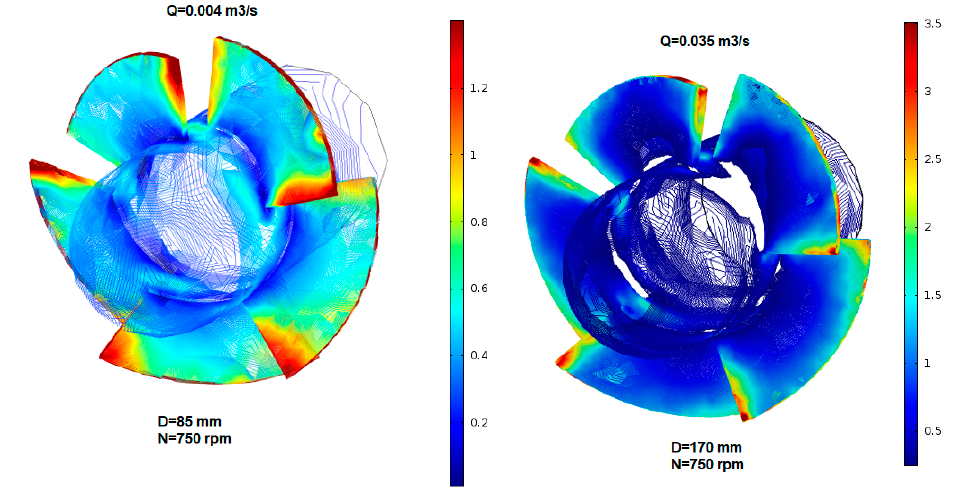
Figure 12. Shear stress distribution contours for D = 85 mm (design conditions) and for D = 170 mm (in Pa).